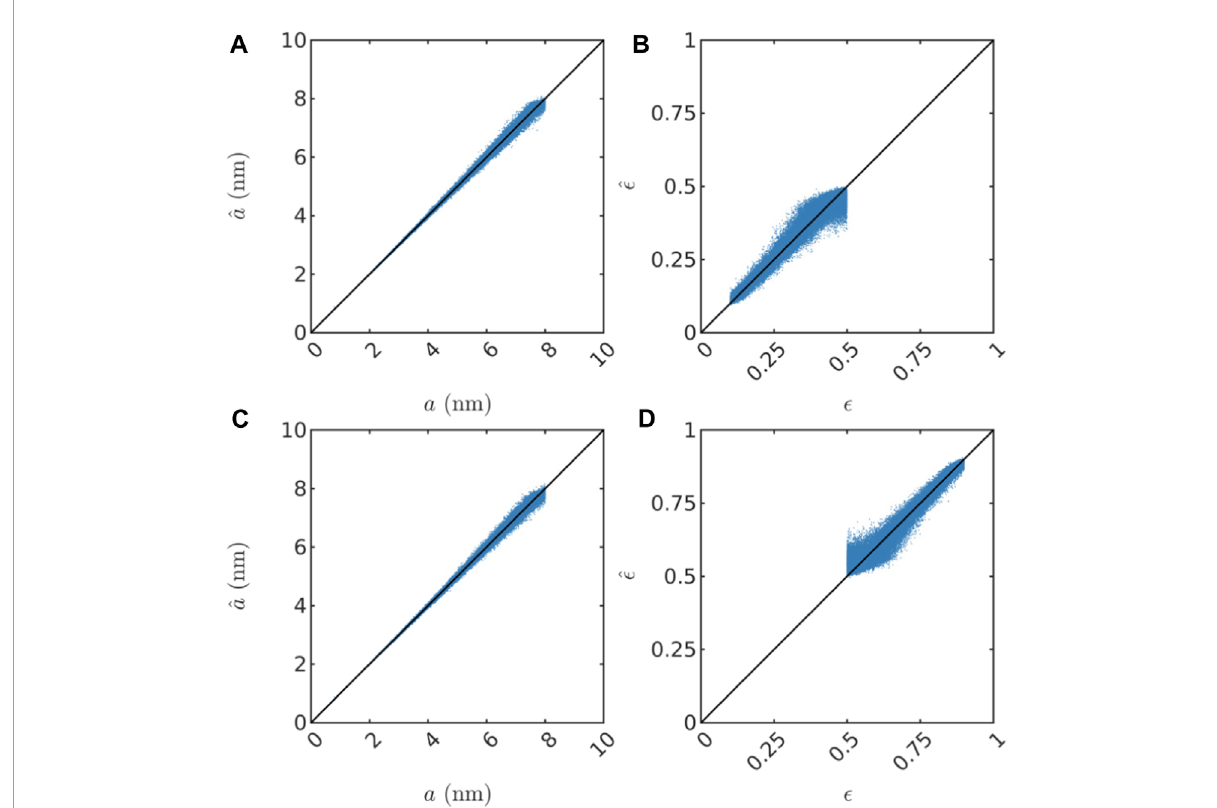
FIGURE 4 Scatter plots showing prediction results on the test set for both two-phase datasets. In (A,B) , predictions of a and ϵ are shown for the two-phase low porosity structures. In (C,D) , predictions of a and ϵ are shown for the two-phase high porosity